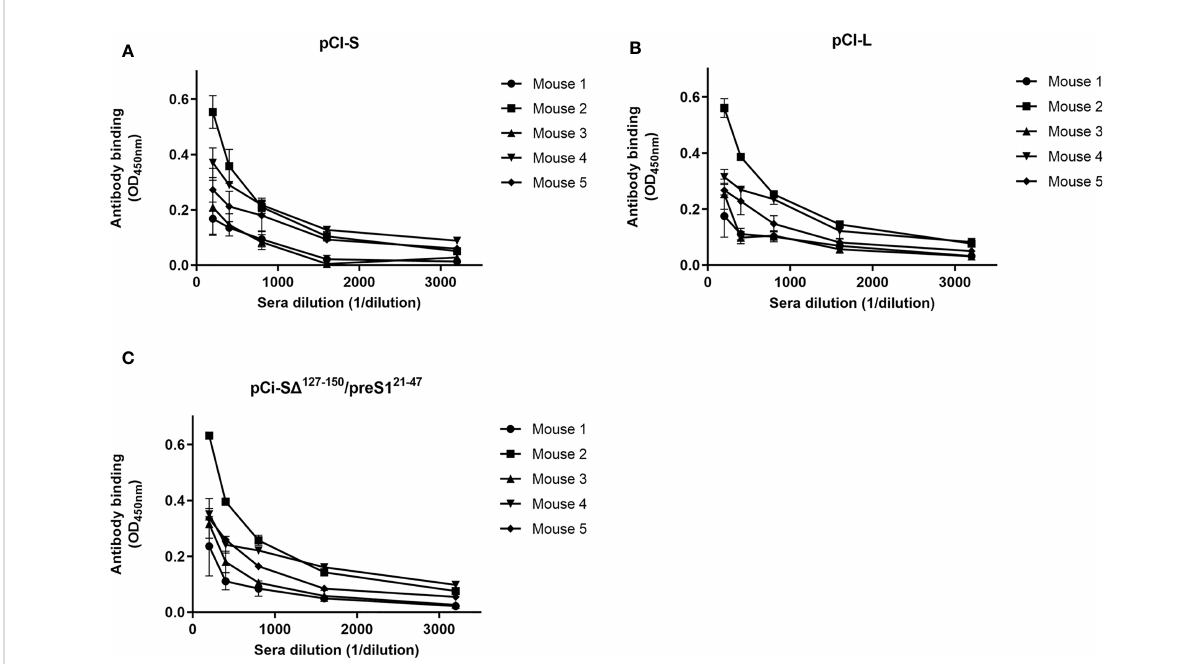
FIGURE 7 Binding of antibodies elicited by the HVB-S/preS1 16-42 antigen to HBV surface proteins. Lysates of HEK293T cells transfected with pCi plasmids encoding for the S, (A) , L (B) , and S D 127-150 /preS 121-47 (C) proteins were used to coat 96-well plates. Serial dilutions of pooled pre-immune sera and of sera from mice immunized with S/preS1 16-42 were added to the plates, followed by incubation with HRP-conjugated anti-mouse secondary antibodies. Antibody binding is shown as optical density values measured at 450 nm following subtraction of those obtained for the pre-immune sera (n=3). Data are represented as means ± SD for each individual